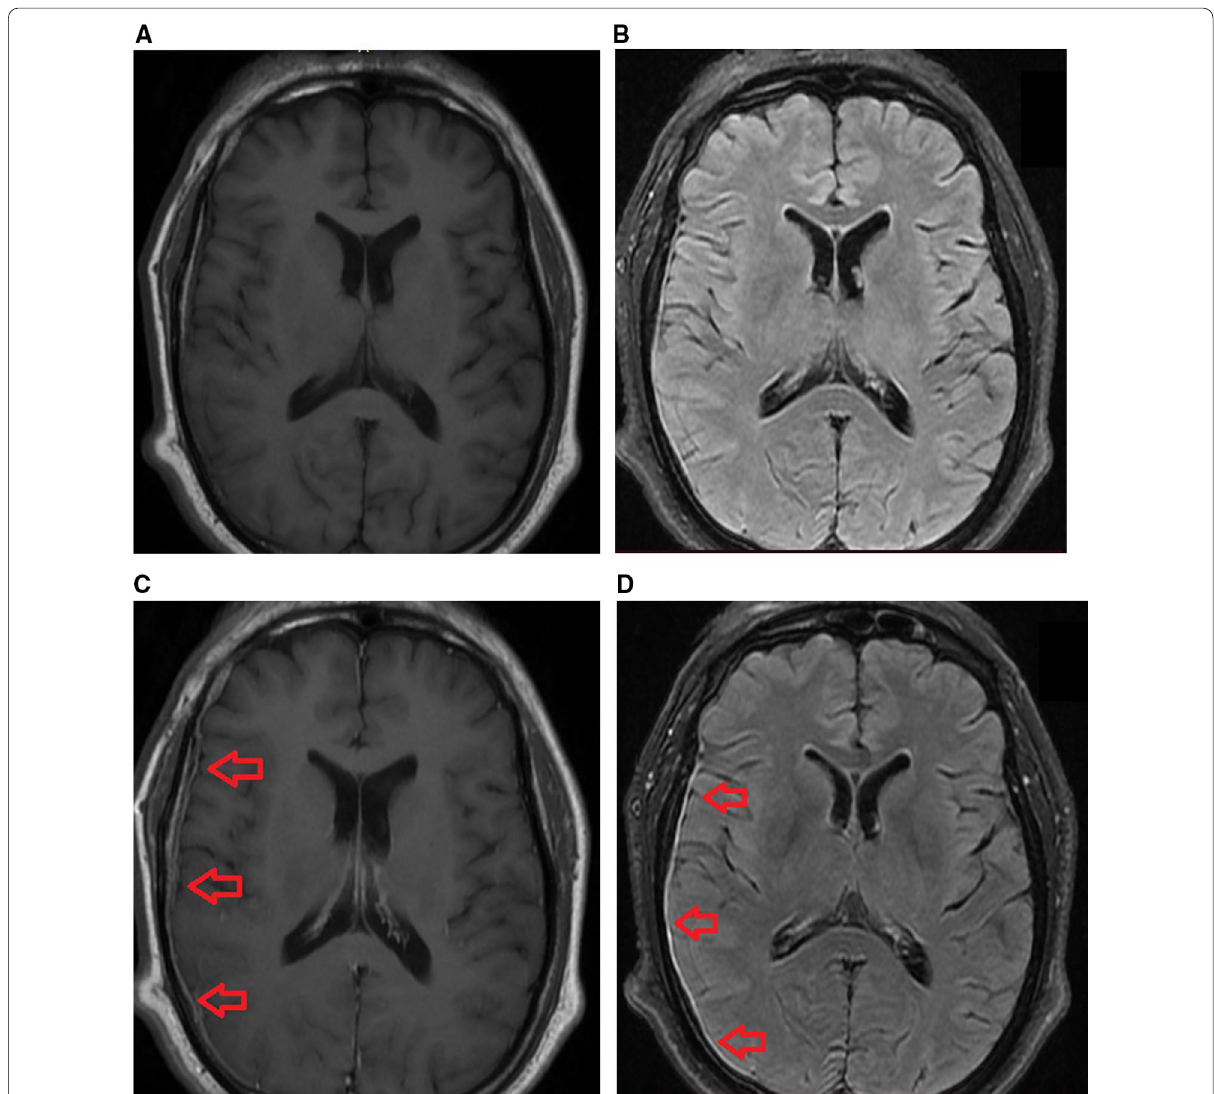
Fig. 4 A 75-year-old male patient with known history of lung cancer. MRI revealed diffuse dural thickening along the right cerebral hemisphere, showing equal pachymeningeal linear enhancement on CE-T1WI and DPC-FLAIR. A Axial pre-contrast T1WI. B Axial FLAIR. C Axial CE-T1WI. D